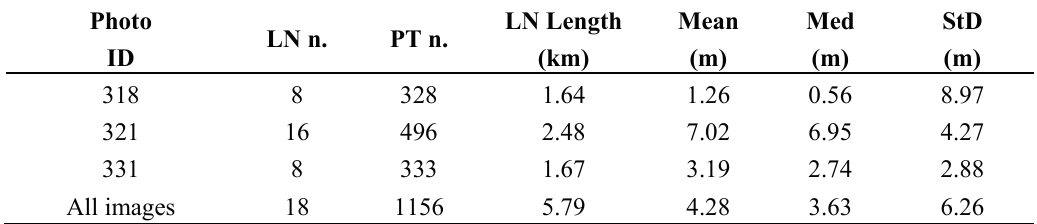
Table 5. Test 5—2011 lava flow in Valle del Bove (Mount Etna): statistics on the distance between natural linear features measured on the 19 January 2011 DOs and on the 2005 orthophoto: number of measured lines (LN n.), number of point along the 2011 linear features (PT n.), line (LN) length, mean and median (Med) values as well as standard deviations (StD) of point-line